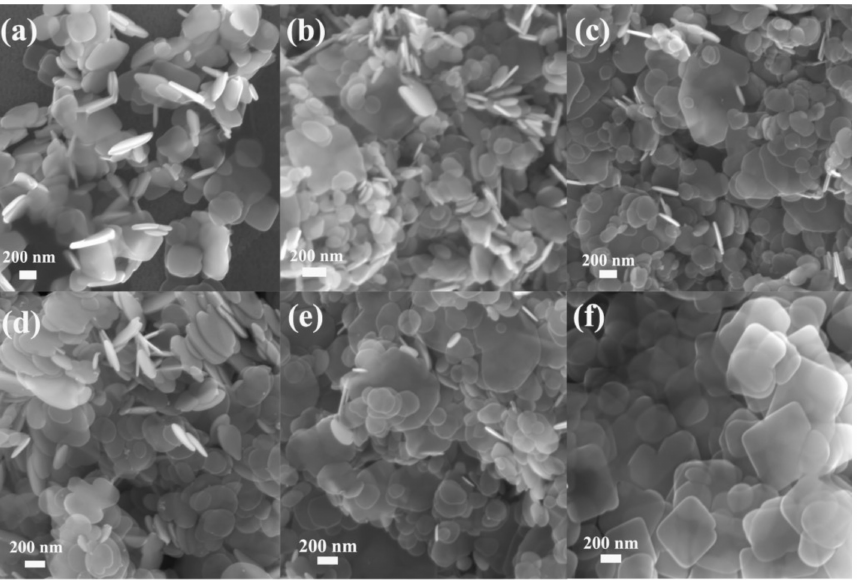
Figure 2. SEM image of ultrathin BiOBr X I 1 − X nanosheets: ( a ) BiOI; ( b ) BiOBr 0.05 I 0.95 ; ( c ) Bi- OBr 0.10 I 0.90 ; ( d ) BiOBr 0.15 I 0.85 ; ( e ) BiOBr 0.20 I 0.80 ; and ( f )